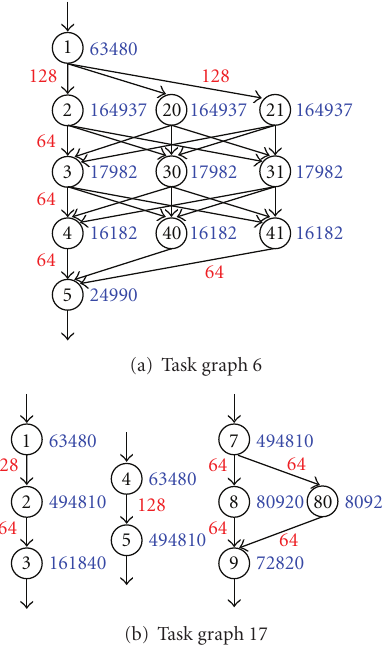
Figure 7: Examples of the task graphs used.